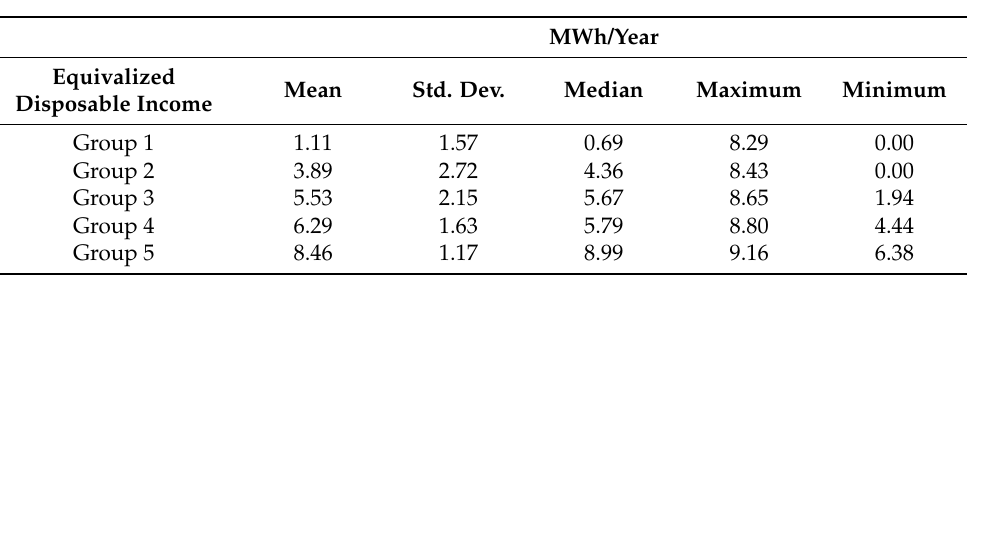
Table 4. Statistical data of household